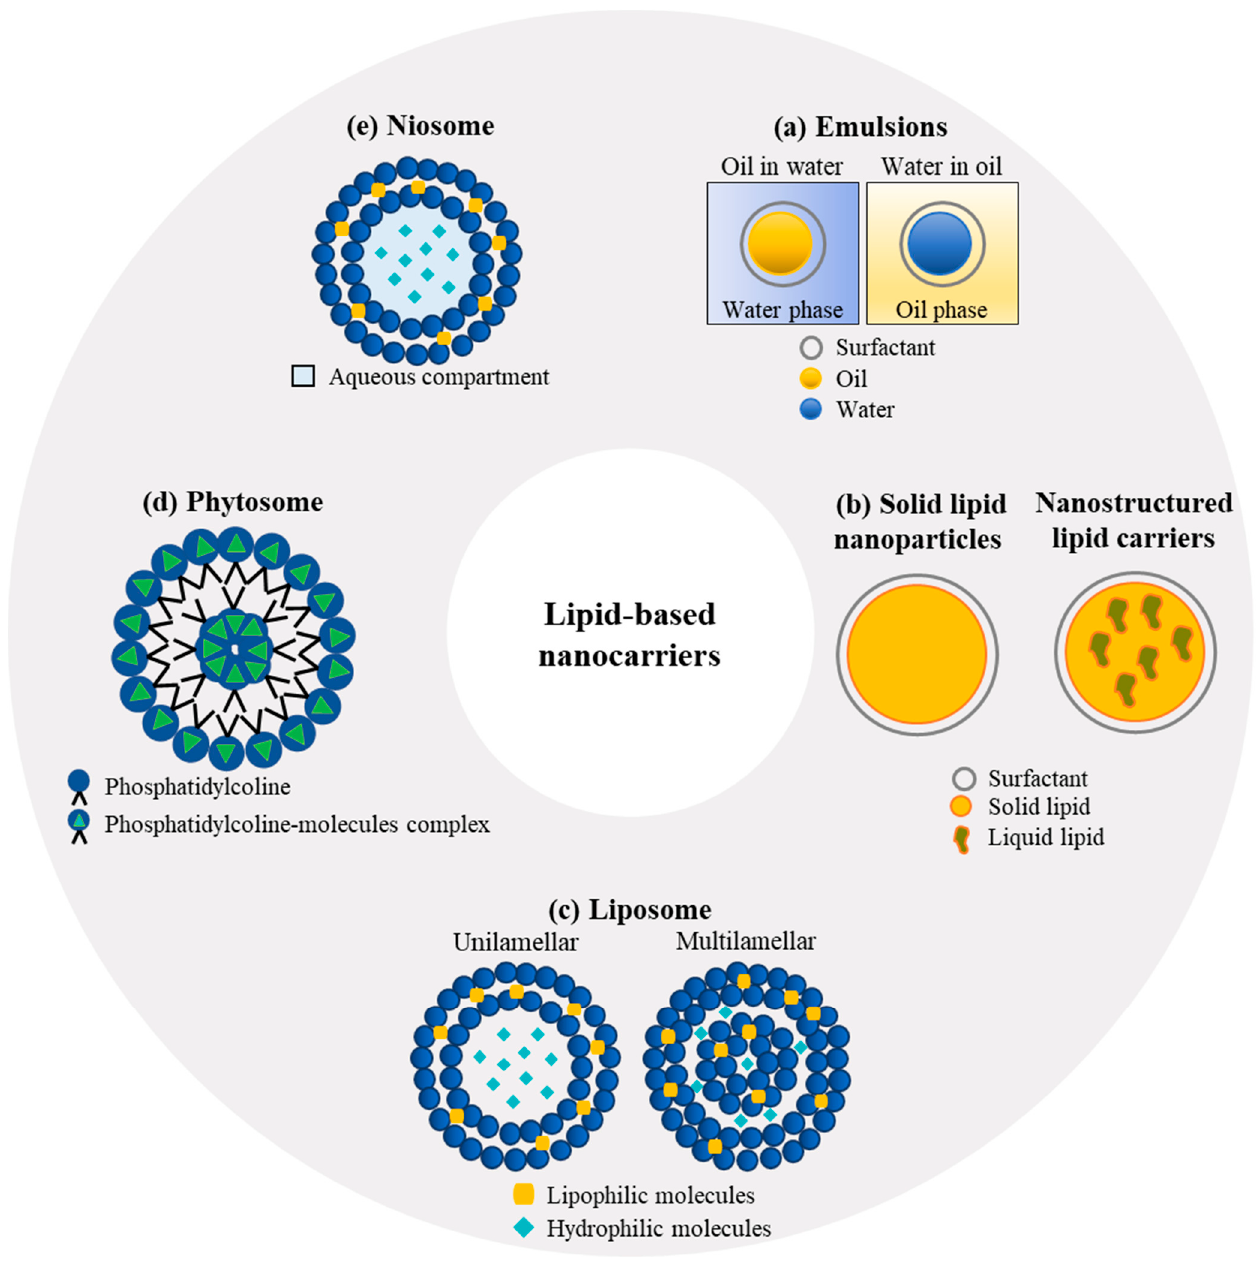
Figure 6. Main lipid ‐ based systems for the delivery of lipophilic and hydrophilic